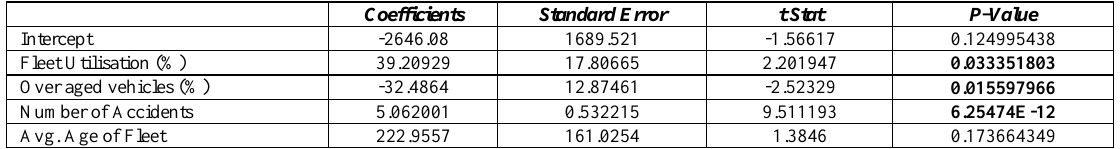
Table 7. Regression analysis for fleet size